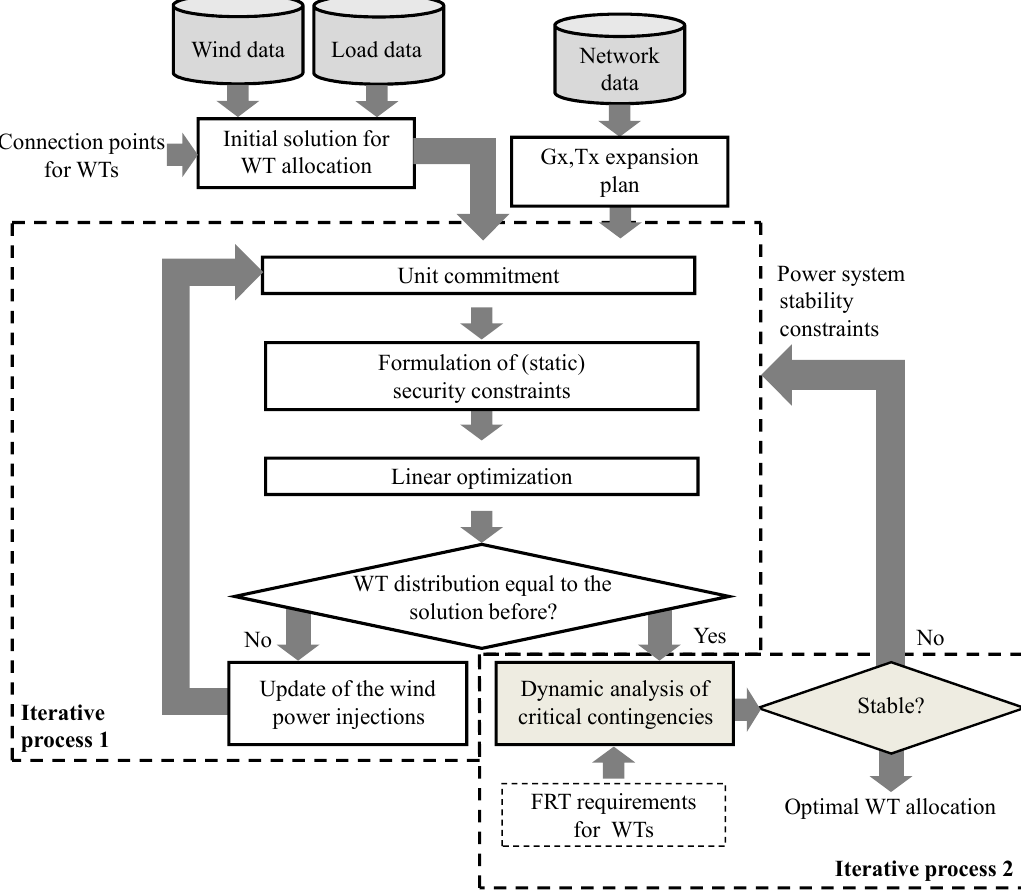
Figure 1. Methodological approach for WT network